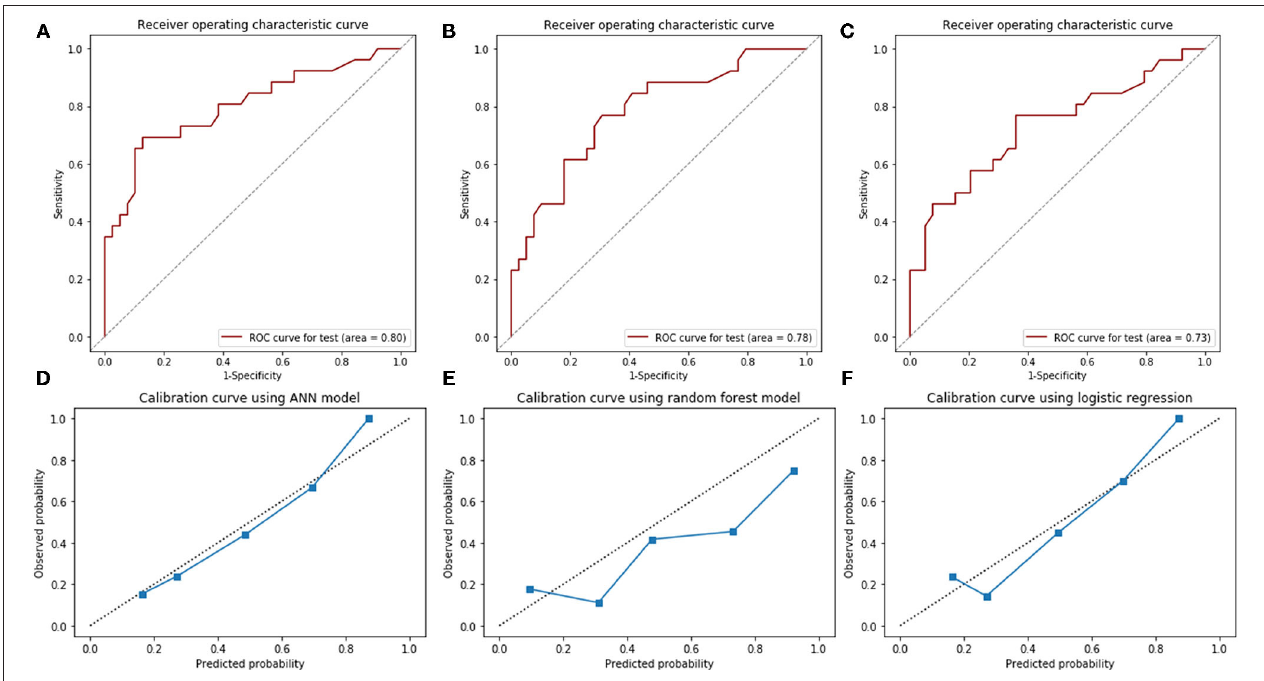
TABLE 4 | Comparison of performance between different models. Model